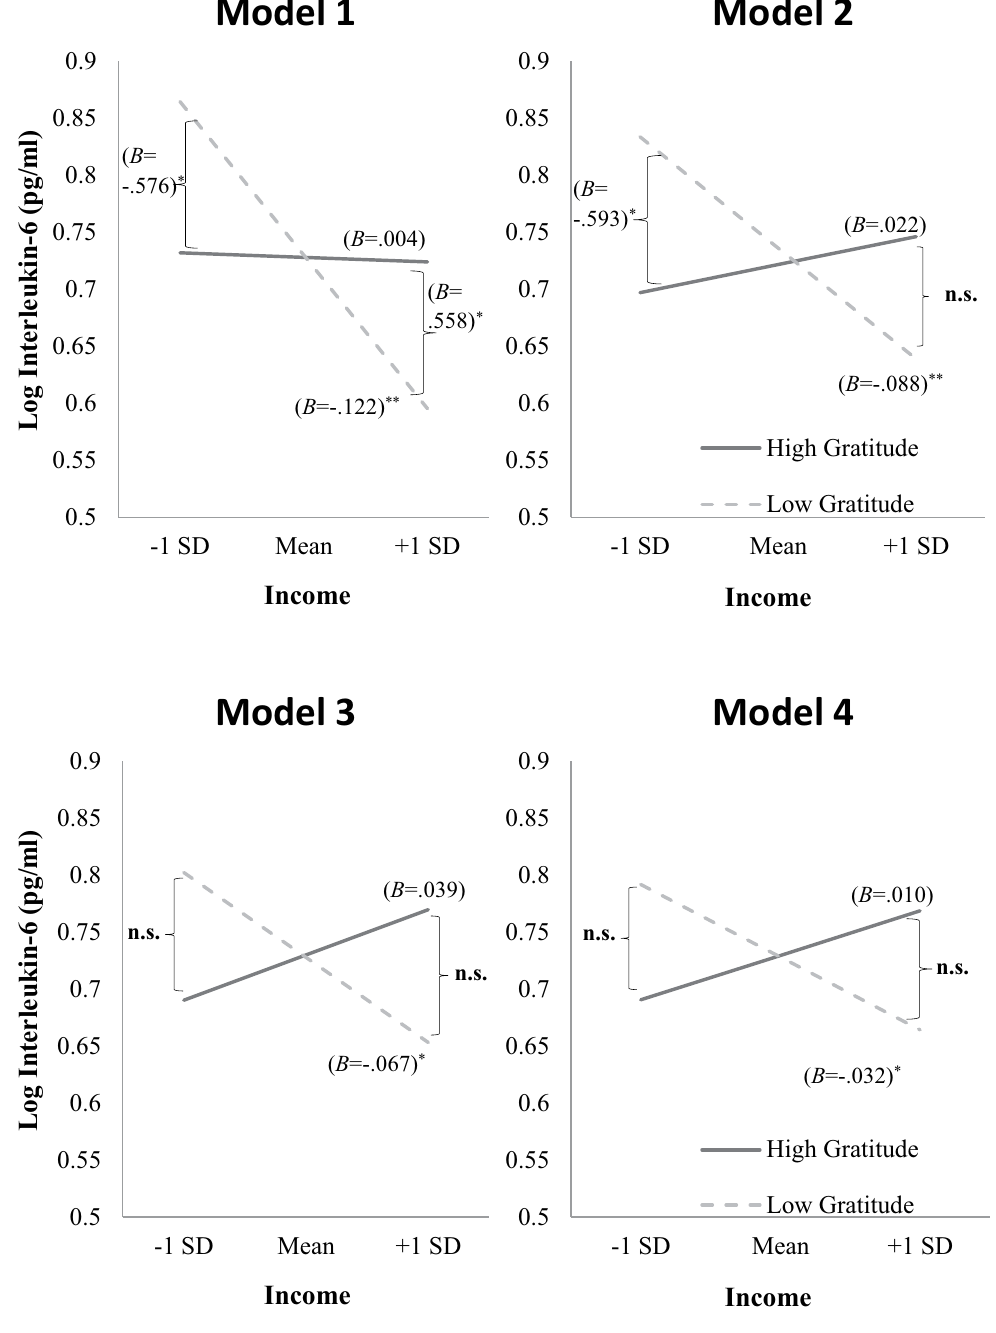
Figure 2. Simple slopes (i.e., unstandardized coefficients) of income predicted interleukin-6 when trait gratitude was 1 SD above and below the mean across the four models (adjusted and unadjusted models). n.s. = not significant. * p < 0.05, ** p <